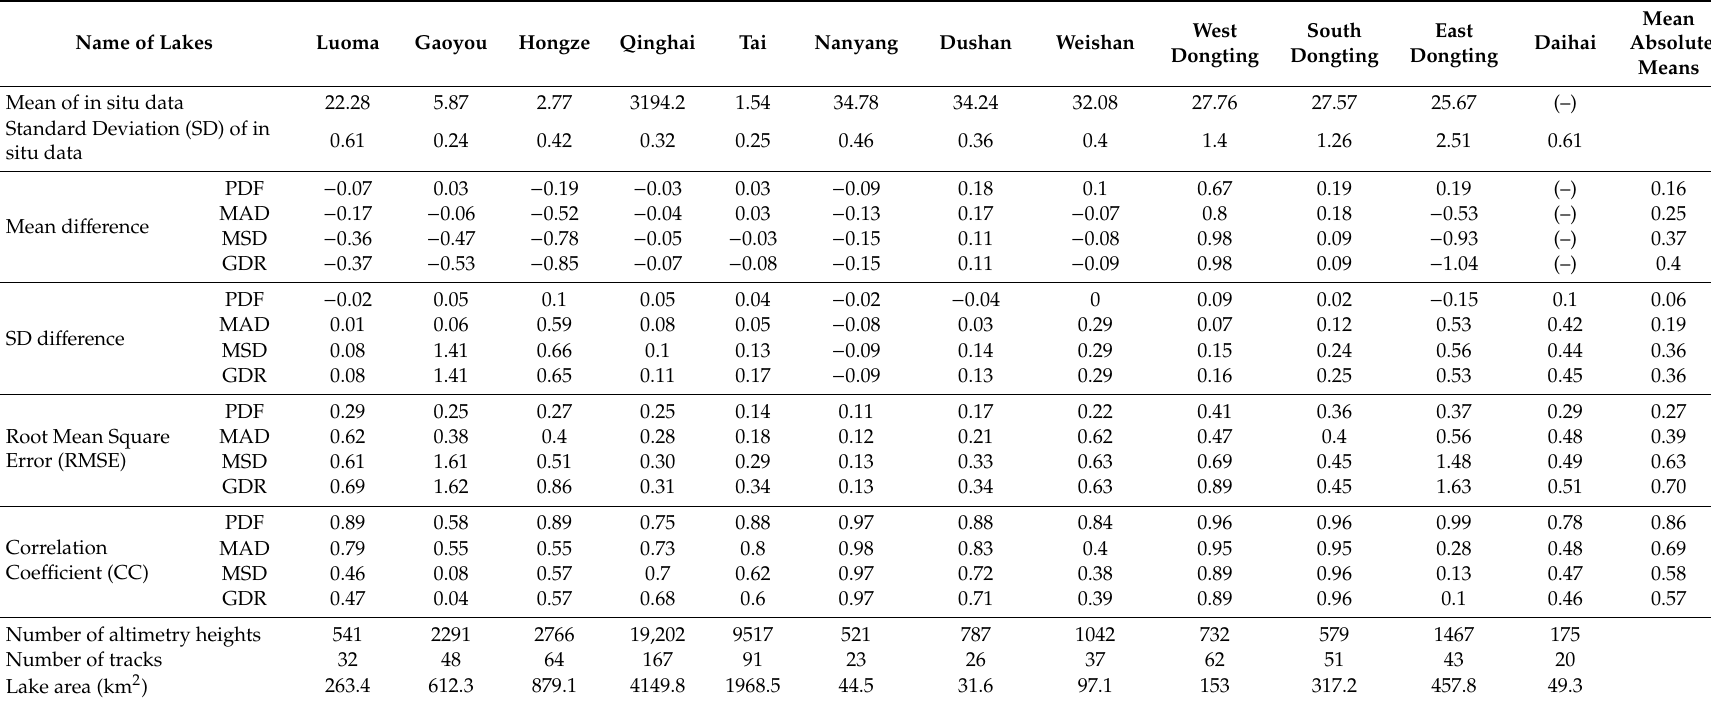
Table 1. Evaluation results of the CryoSat-2 water levels by in situ gauge data. Note: “GDR” is raw